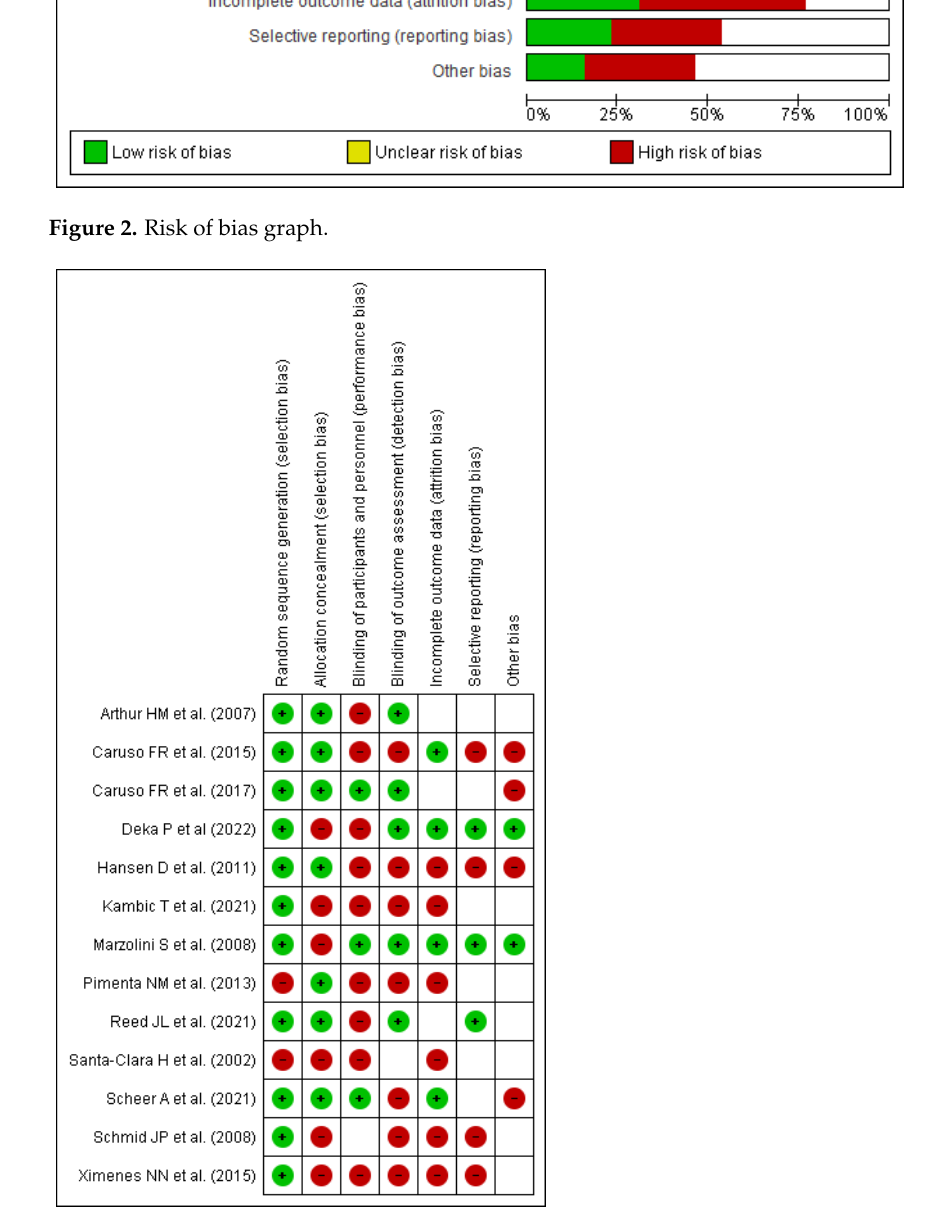
Figure 3. Risk of bias summary of included articles for review